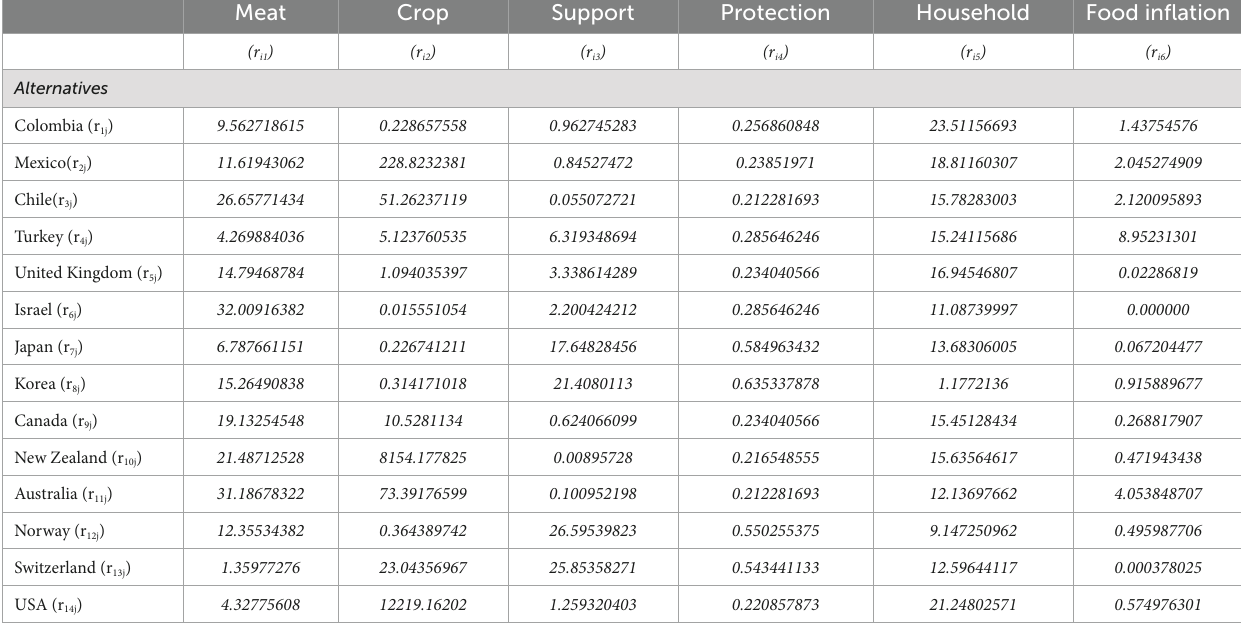
TABLE 6 Normalized matrix result. Meat Crop Support Protection